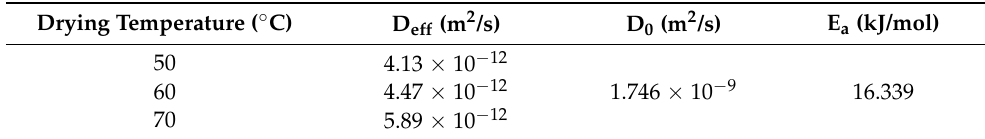
Table 2. Values of effective moisture diffusivity and activation energy in linden leaf samples subjected to IRD.